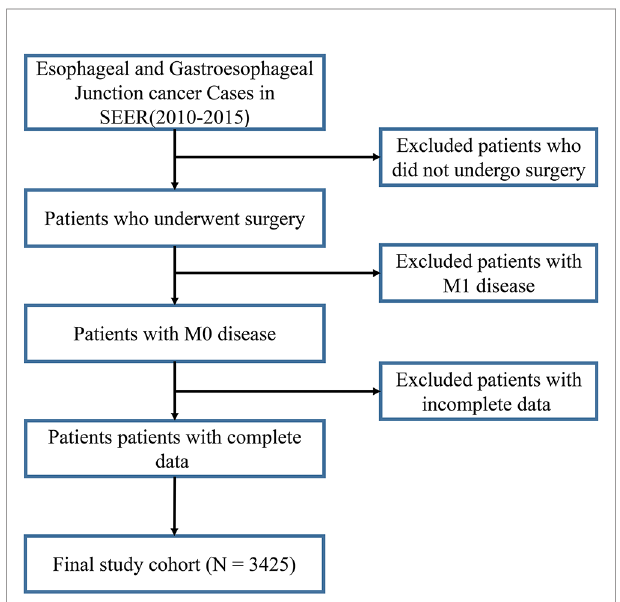
FIGURE 1 | Selection of GEJ patients included in the study. GEJ, Gastroesophageal Junction, SEER, Surveillance, Epidemiology, and End